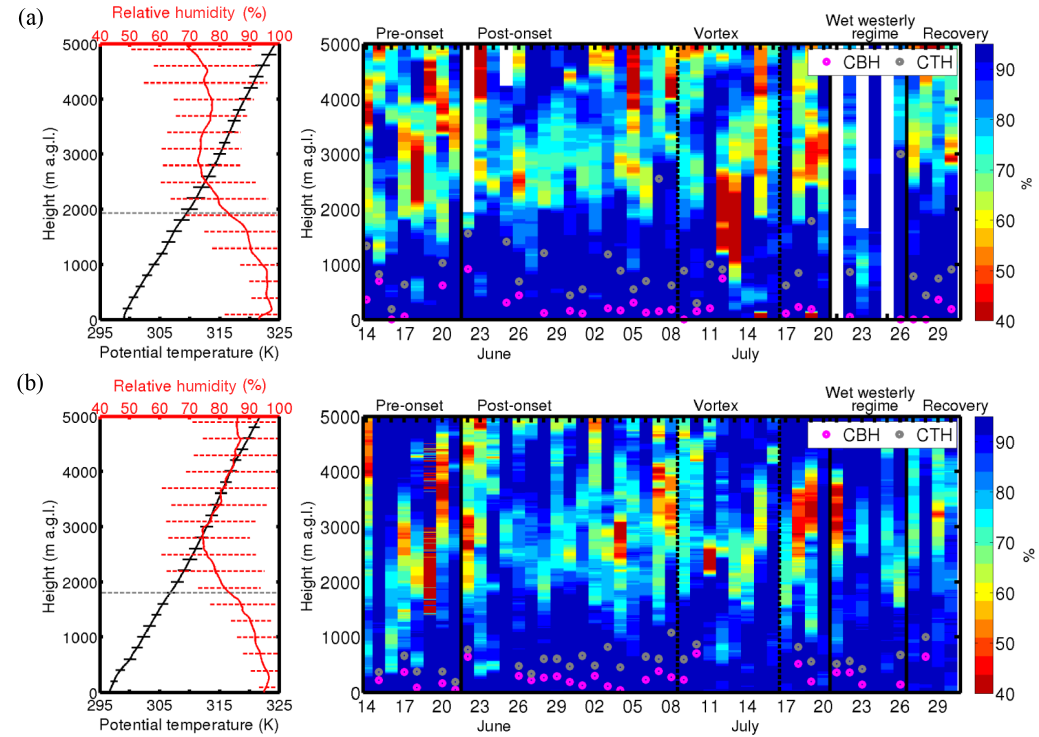
Figure 3. Mean profiles of relative humidity (red solid line) and potential temperature (black solid line) plus their standard deviations based on 06:00UTC soundings at Kumasi (a) and Savè (b) on the left. The horizontal grey dashed line indicates the monsoon height. Times series of relative humidity (colour coded) at 06:00UTC at Kumasi (a) and Savè (b) on the right. The pink and grey circles indicate cloud base and top estimated from the relative humidity profiles respectively. Different phases of the monsoon are indicated according to Knippertz et al.